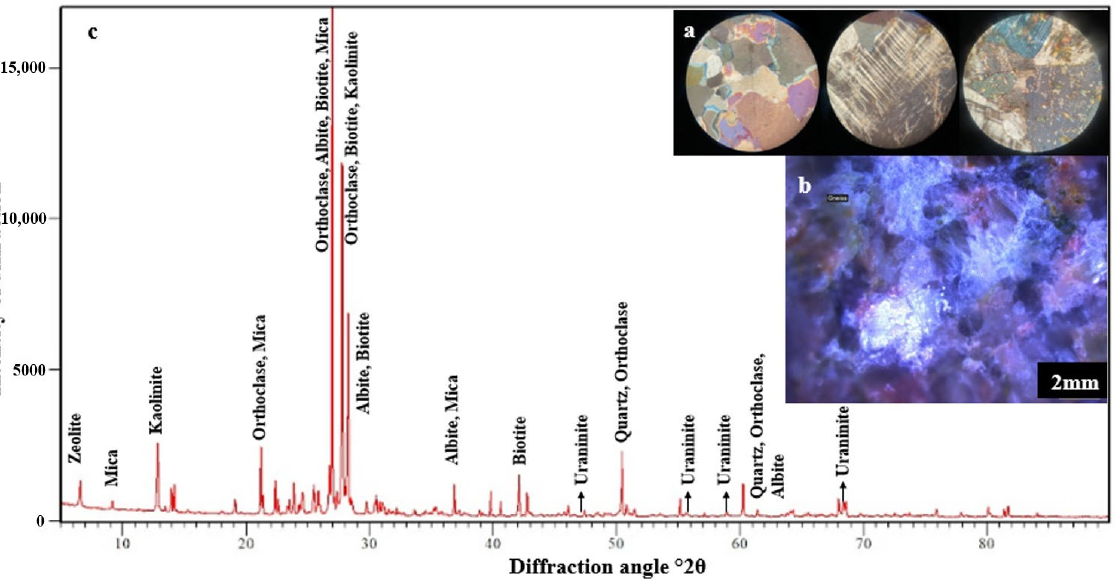
Figure 12. ( a ) Petrographic thin section; ( b ) SEM micrograph; ( c ) XRD of granite rock sample from the study area.